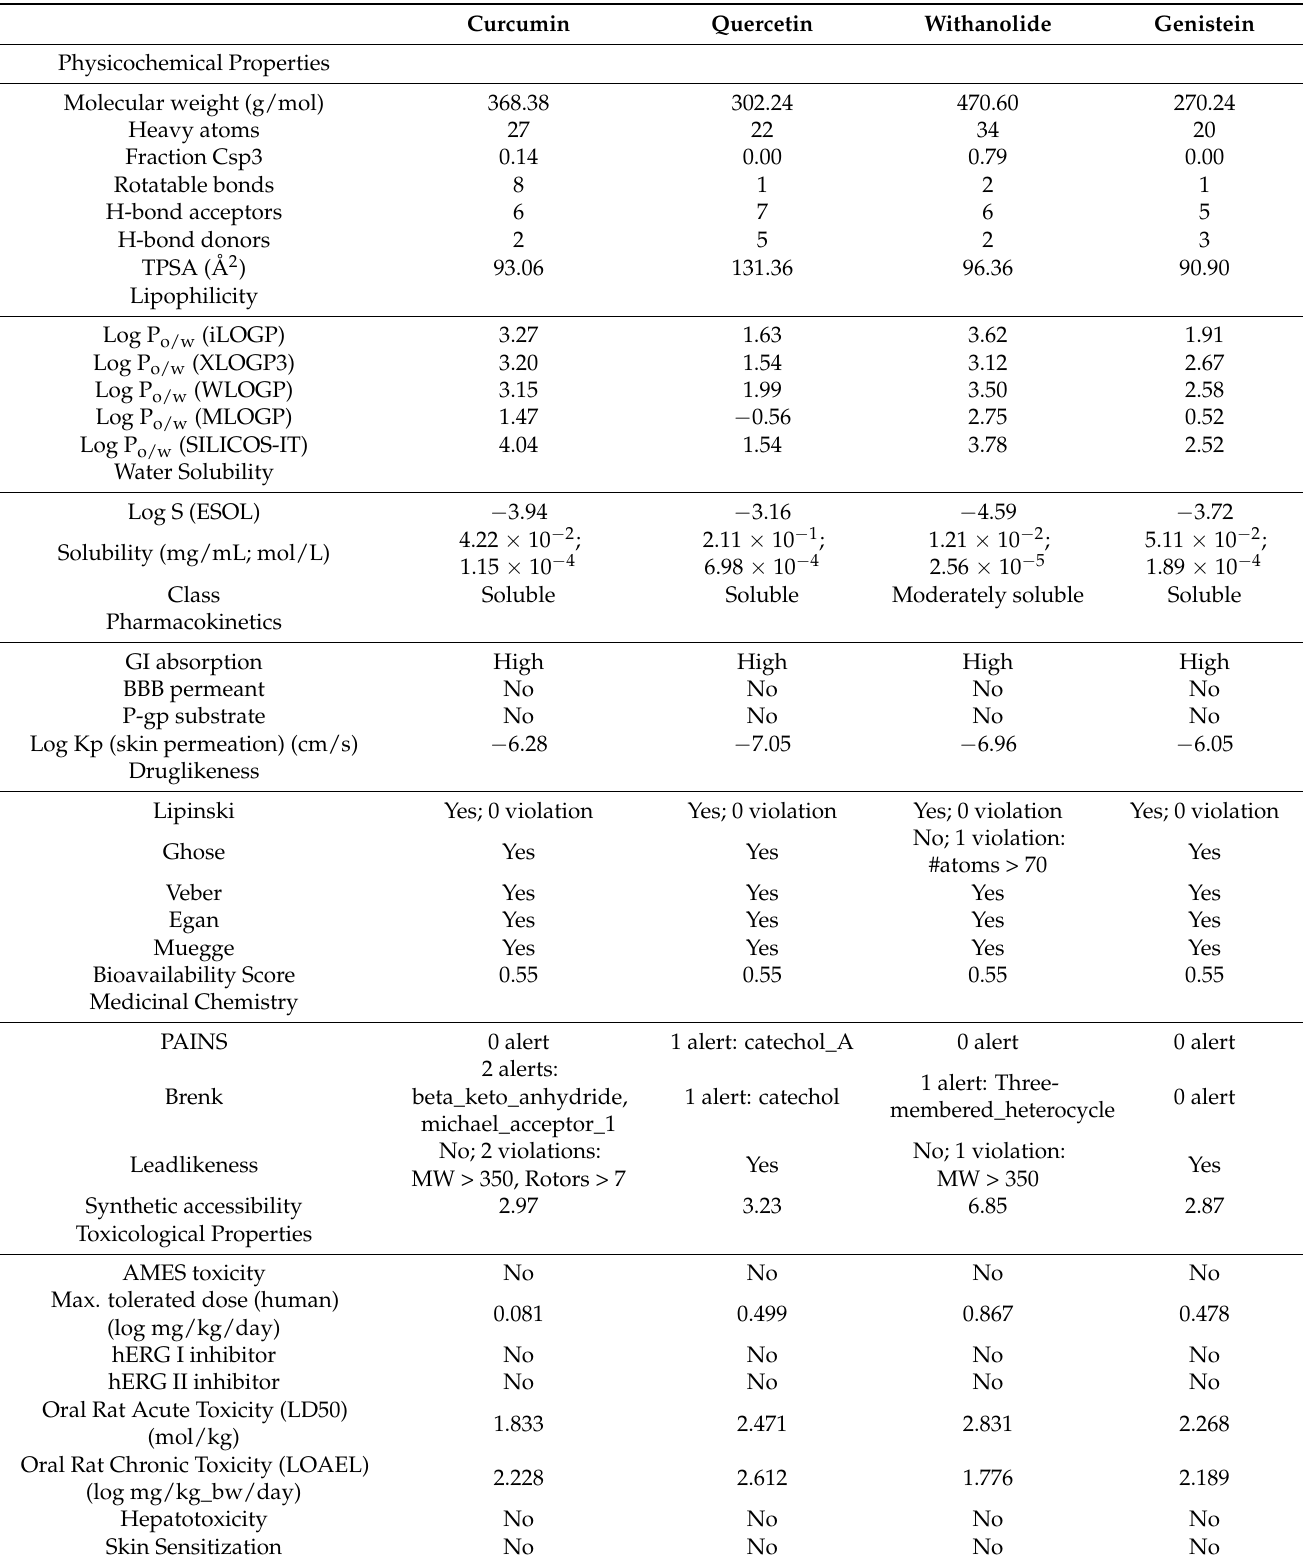
Table 2. Interactions of 6GU7 with curcumin, quercetin, withanolide, and genistein. Curcumin Quercetin Withanolide